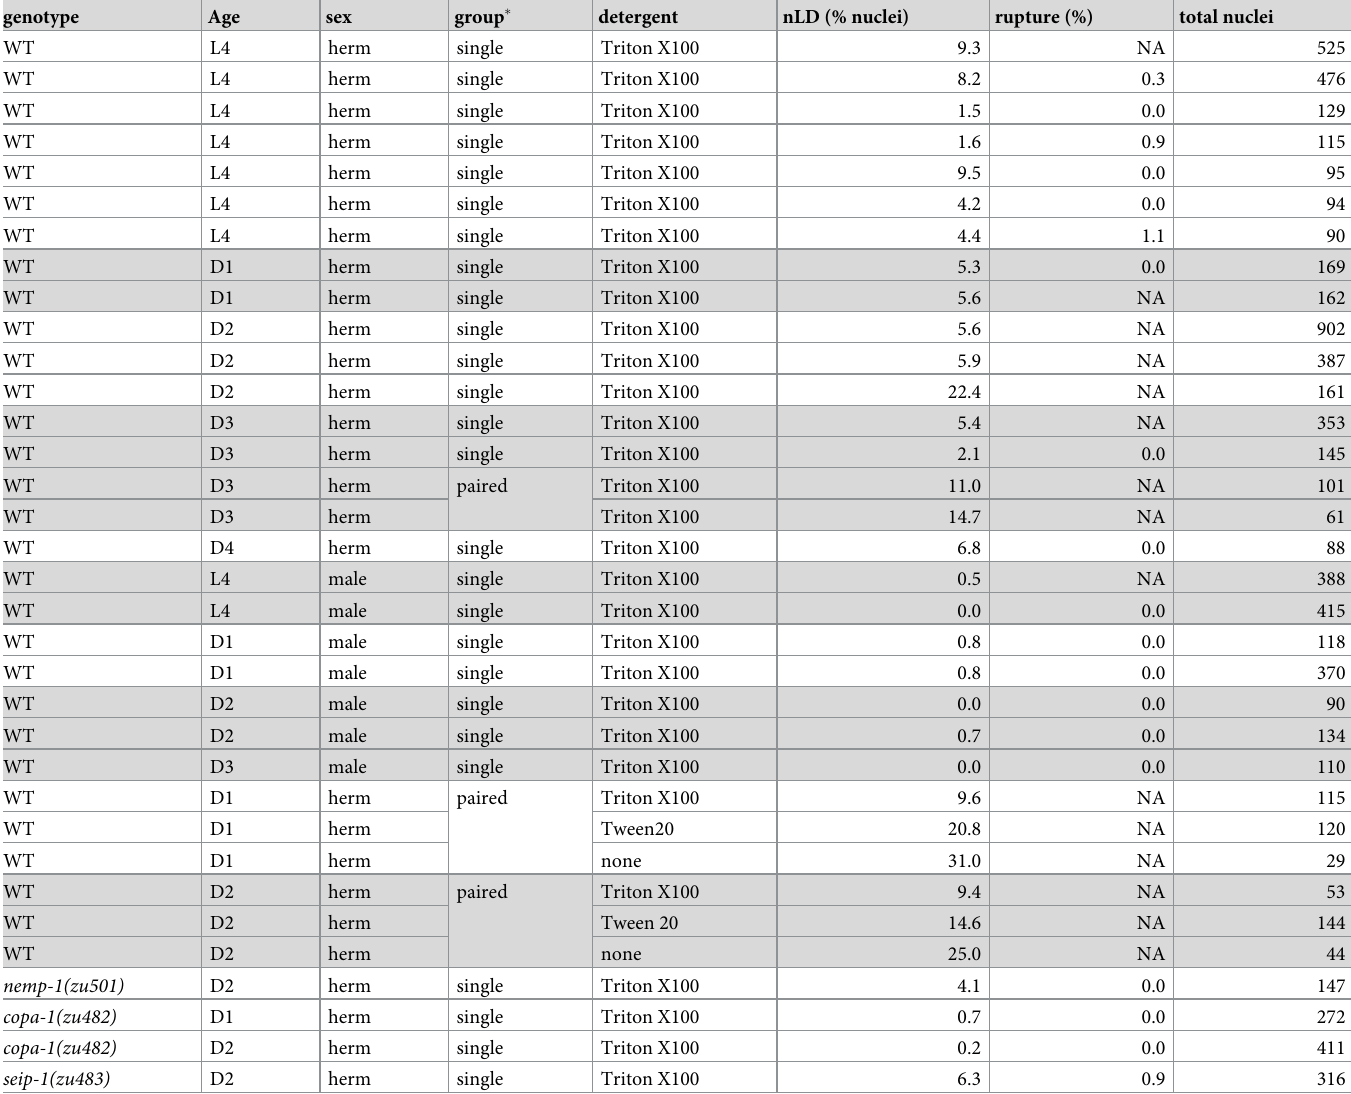
Table 1. nLDs in intestinal nuclei.